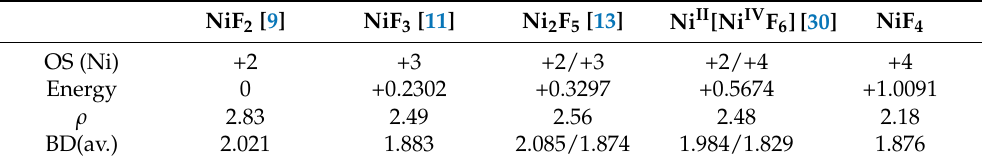
Table 3. Comparison of of different binary nickel fluorides with respect to their formal oxidation state (OS) of nickel, energy (in eV) normalized to the most stable NiF 2 , their densities per formula unit (in a.u.), and average Ni − F bond lengths (BD(av.), in Å). NiF 2 [9] NiF 3 [11] Ni 2 F 5 [13] Ni II [Ni IV F 6 ] [30] NiF 4 OS (Ni) +2 +3 +2/+3 +2/+4 +4 Energy 0 +0.2302 +0.3297 +0.5674 +1.0091